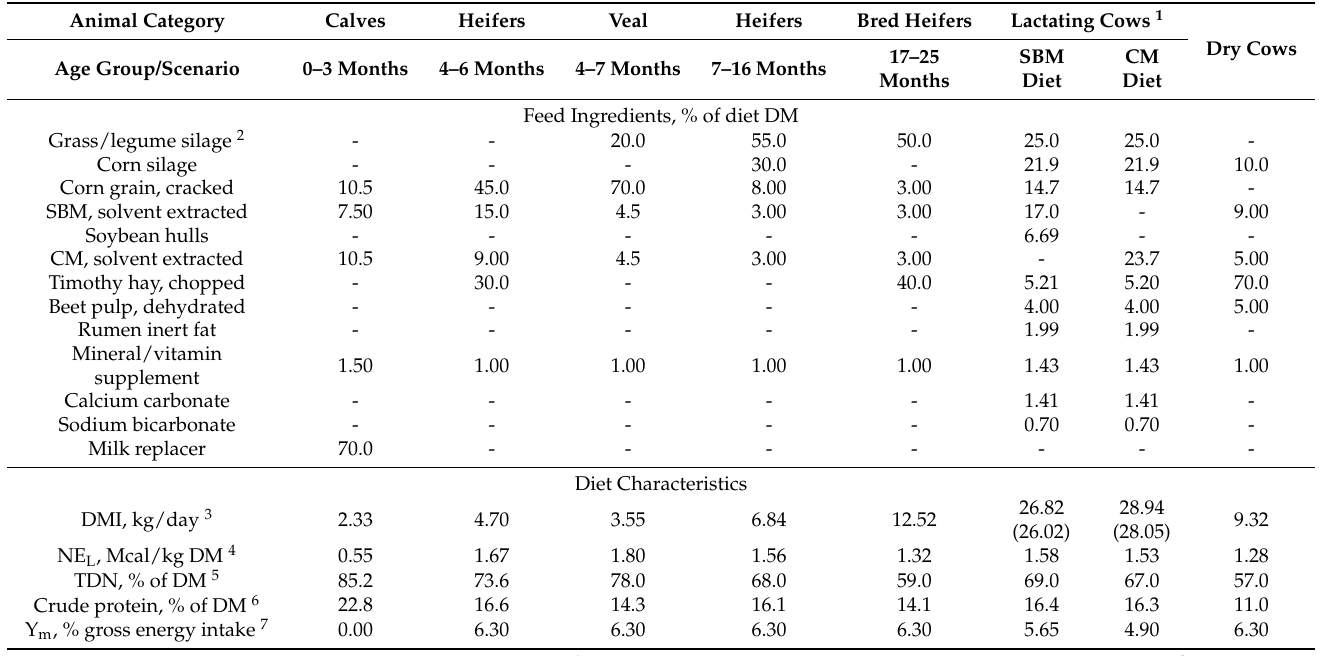
Table 1. Diet ingredients for each animal category for the simulated Quebec dairy farm. Animal Category